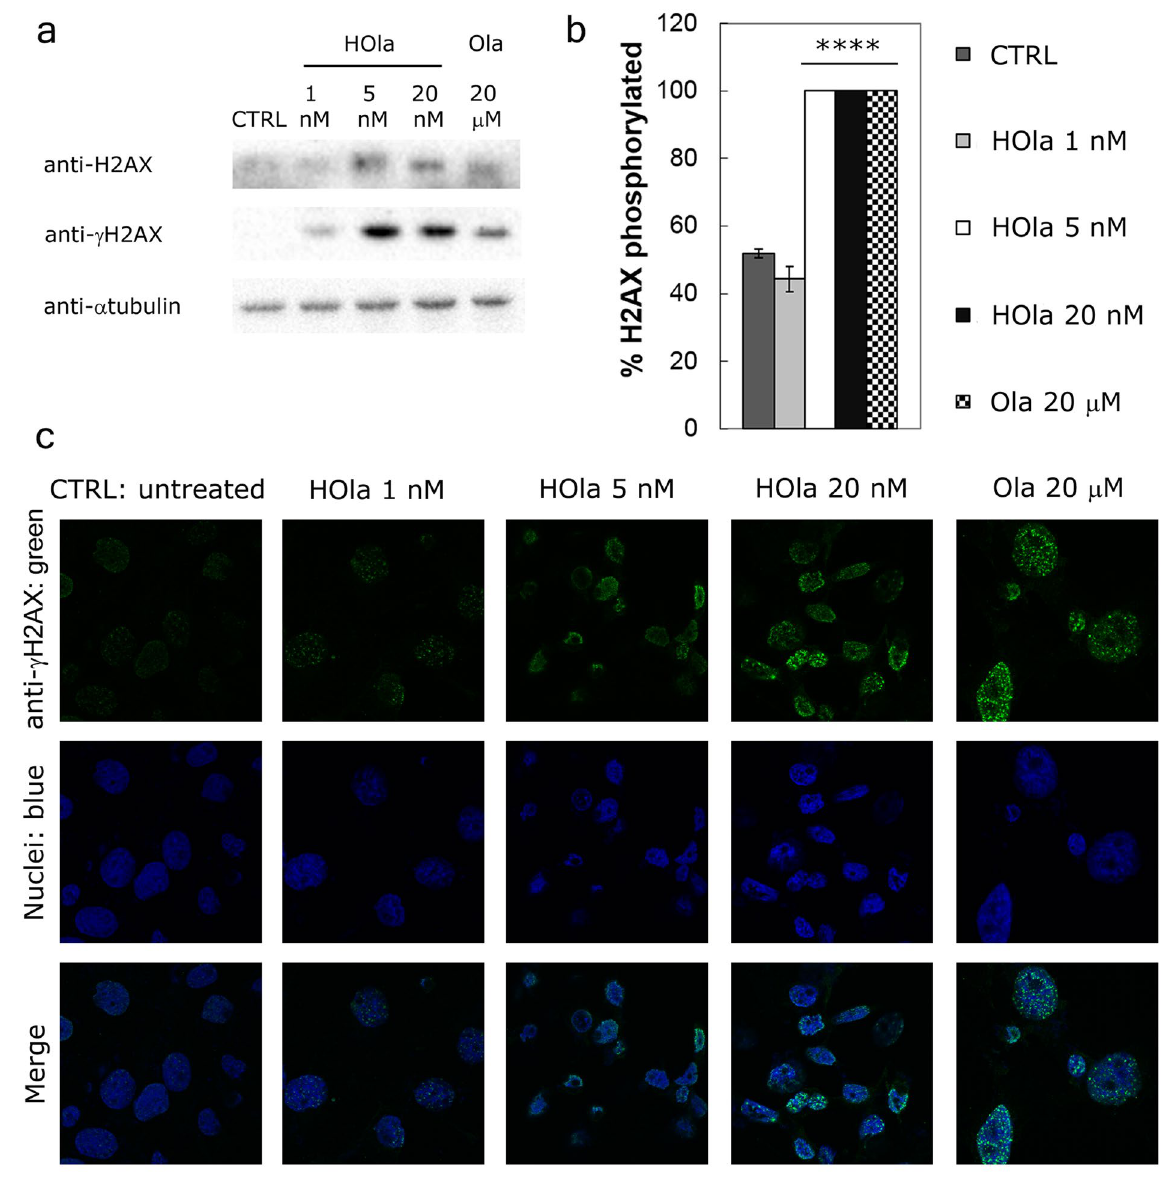
Figure 7. HFn increases Ola propensity to induce DNA damage in TNBC cells. ( a ) HCC1937 were treated with increasing concentration of nanoformulated Ola (HOla; 1, 5 and 20 nM) in the presence of 5% FBS supplemented RPMI1640 medium for 72 h. As a positive control, cells treated with 20 µ M Ola were used. At the end of incubation, cells were lysed and subjected to western blot analysis. ( b ) The percentage of phosphorylated histone H2AX ( γ H2AX) were quantified by densitometry using ImageJ Software. Reported values are the mean of 6 samples ± s.e. Statistical significance vs . CTRL, **** P < 0.0001 (Student’s t -test). ( c ) Confocal microscopy images of HCC1937 cells treated with increasing concentration of nanoformulated Ola (HOla; 1, 5 and 20 nM) in the presence of 5% FBS supplemented RPMI1640 medium for 72 h. As positive control, cells treated with 20 µ M Ola were used, while untreated cells were used as negative control (untreated). Nuclei were stained with DAPI (blue). DNA damage was recognized with anti- γ H2AX antibody and labeled with an anti-rabbit secondary antibody conjugated with Alexa Fluor 488 (green; Thermo Fischer Scientific). Scale bar: 10 µ